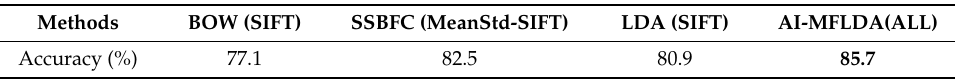
Table 7. Classification results of the different methods on the 800 unlabeled aurora